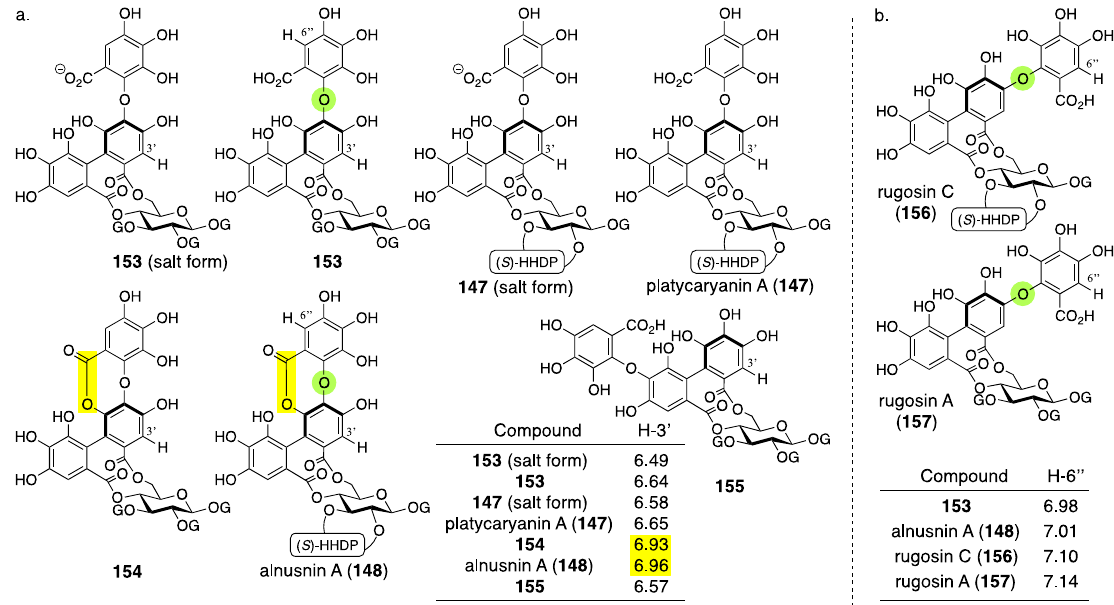
Figure 52. The notable difference of the 1 H-NMR chemical shift observed ( a ) between the lactonized and non-lactonized forms of the tergalloyl moieties and ( b ) between the tergalloyl and valoneoyl moieties. Yellow indicates lactone. Green indicates the oxygen of diaryl ethers listed in the Table in ( b ).